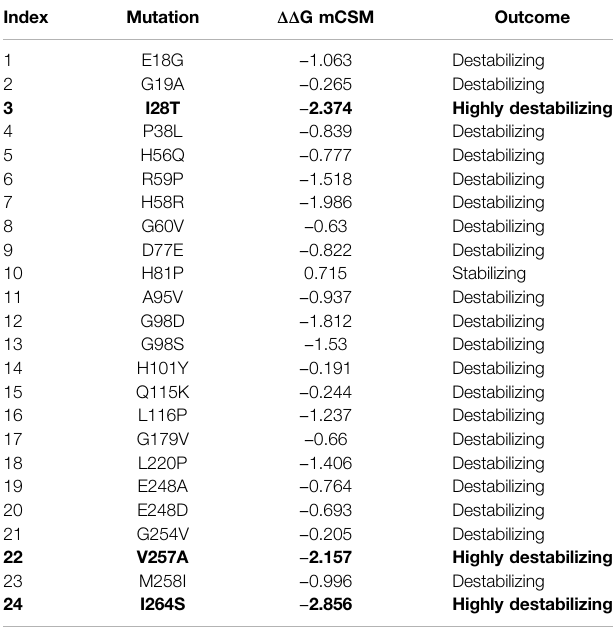
TABLE 2 | A list of 24 highly deleterious mutations was processed to identify the highly destabilizing mutations.